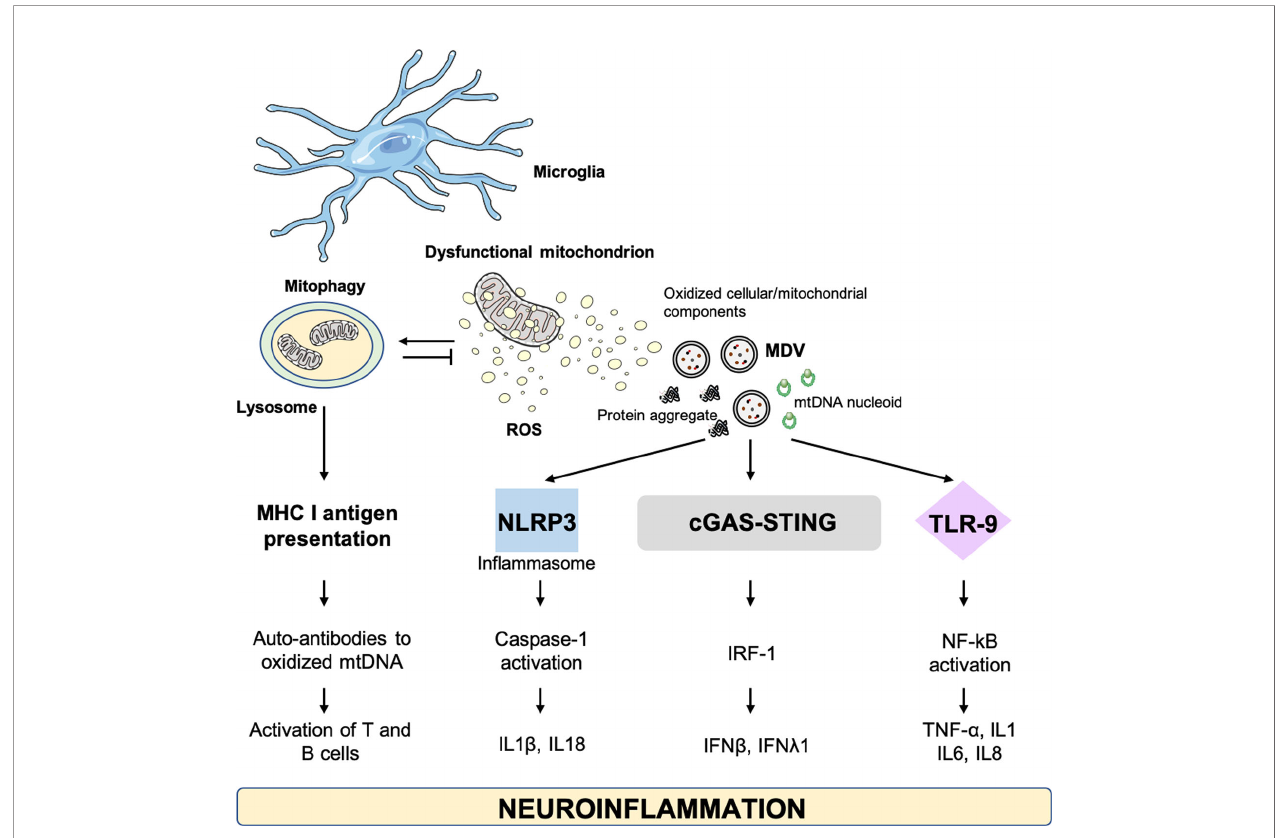
FIGURE 4 | Cellular alterations and damage-associated molecular patterns involved in neuroin fl ammation. cGAS – STING, GMP-AMP synthase – stimulator of interferon genes; IFN, interferon; IL, interleukin; IRF-1, IFN-regulatory factor 1; MDV, mitochondrial derived vesicle; MHC, major histocompatibility complex; mtDNA, mitochondrial DNA; NLRP3, NOD-like receptor 3; NF-kB, nuclear factor kappa B; TLR, toll-like receptor; TNF- a , tumor necrosis factor